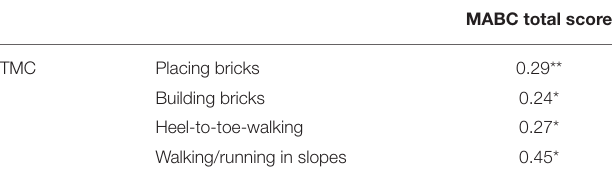
TABLE 2 | The inter-correlation between total score MABC and the four tasks from TMC (* P < 0.05; ** P <